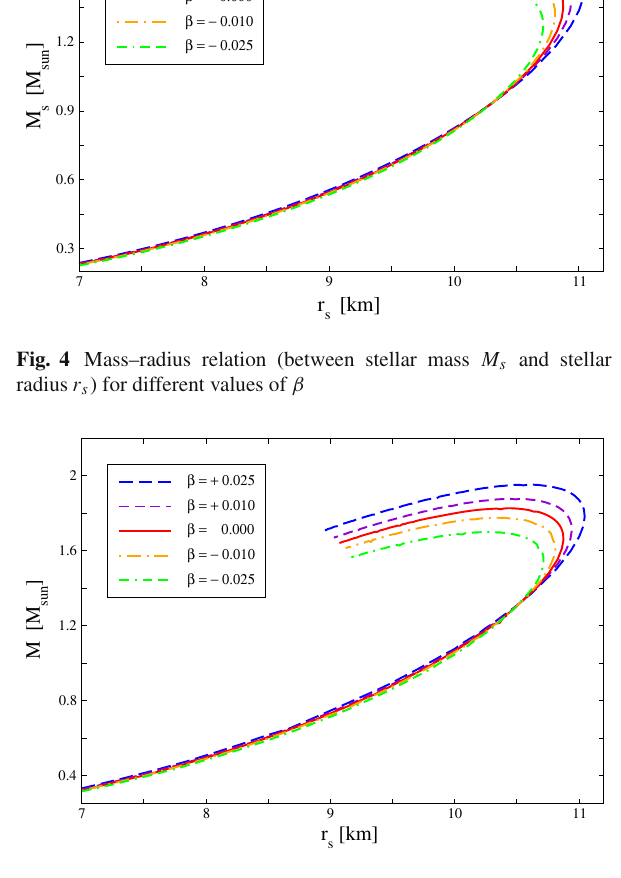
Fig. 5 Total mass M measured by a distant observer versus stellar radius r s for different values of